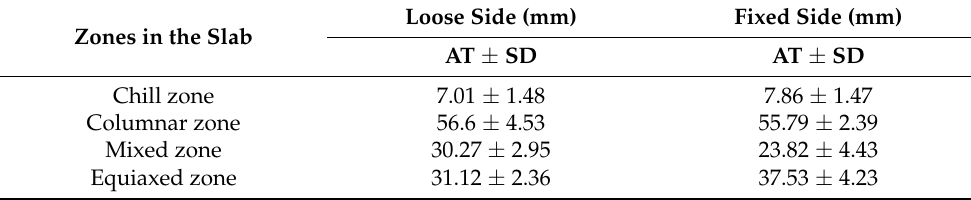
Table 3. Thickness of different solidification zones in the transverse section of the